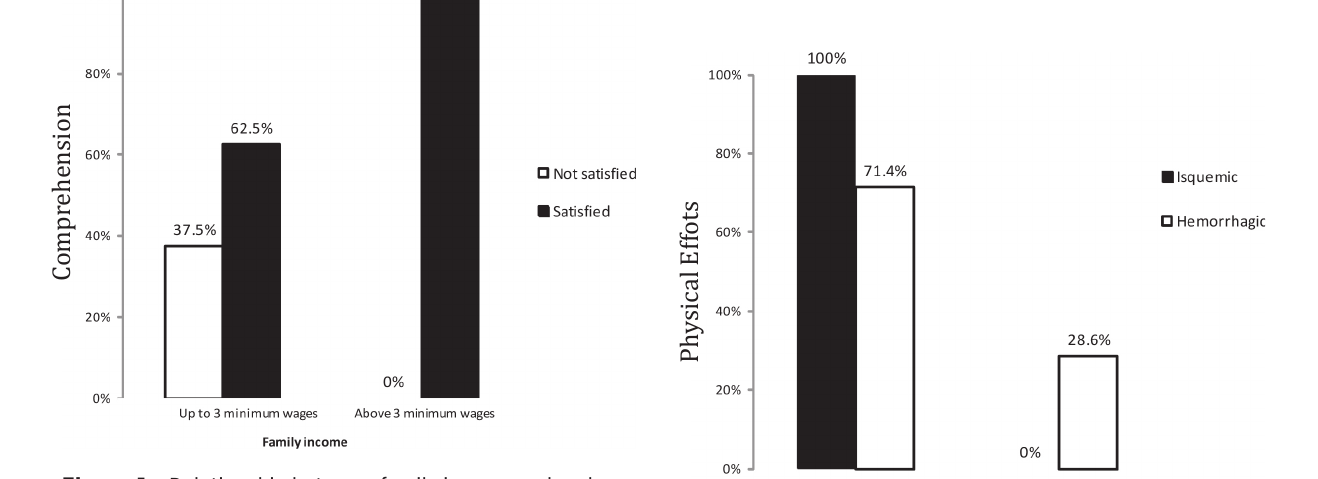
Figure 1 - Relationship between family income and under- standing of the game.